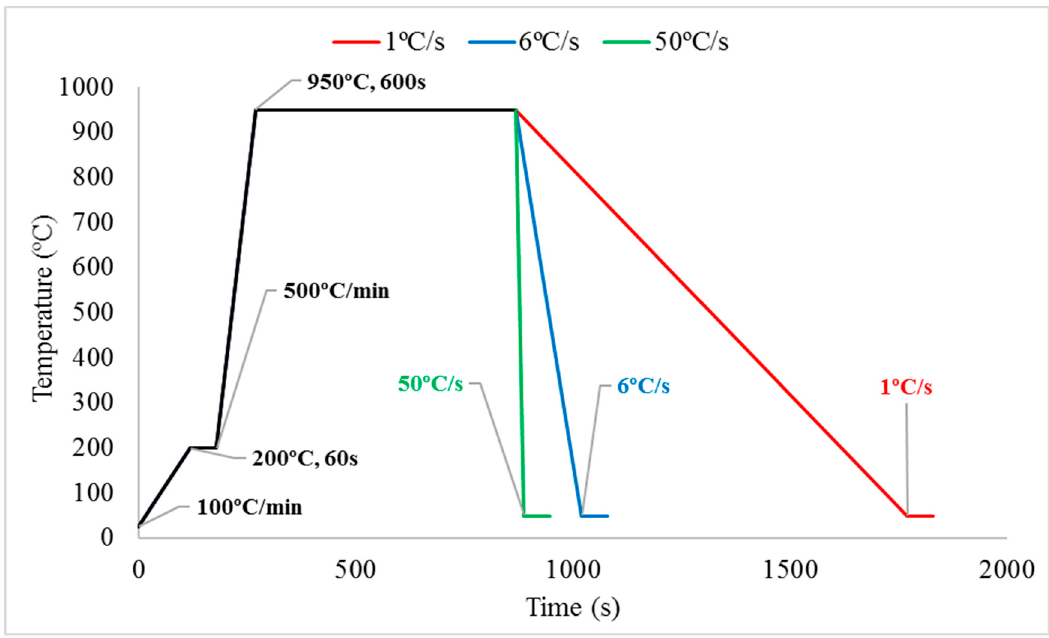
Figure 1. The schematic diagram of different quenching rate experiments for formation of DS and TS TS steels.